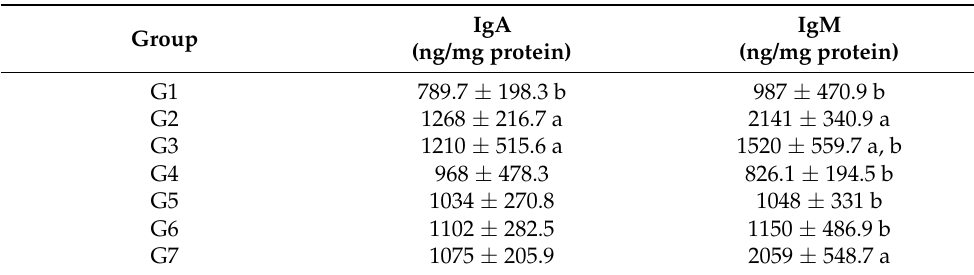
Table 5. Immunoglobulin profile of broilers prophylactically treated with toltrazuril formulations at 21 days of